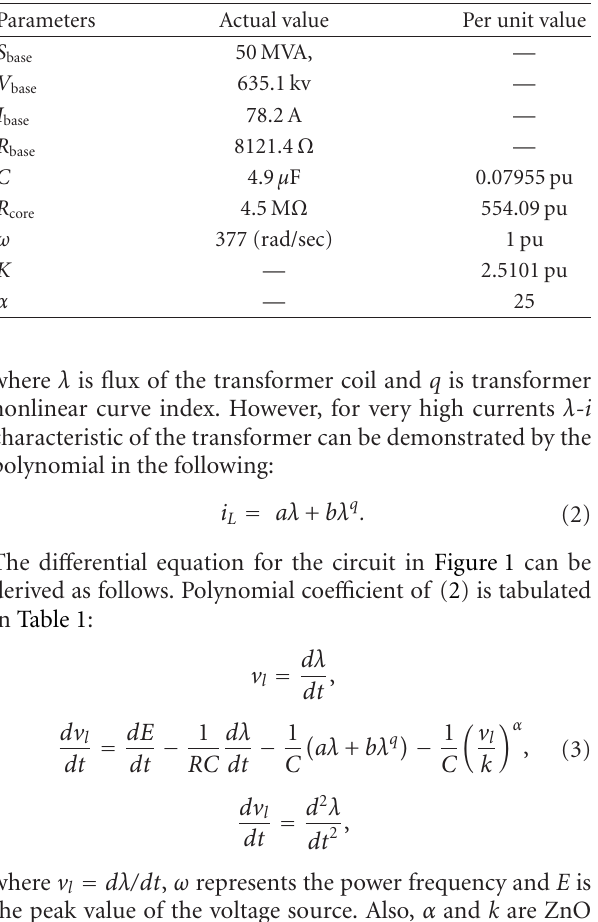
Table 2: Power system parameters considered for simulation.